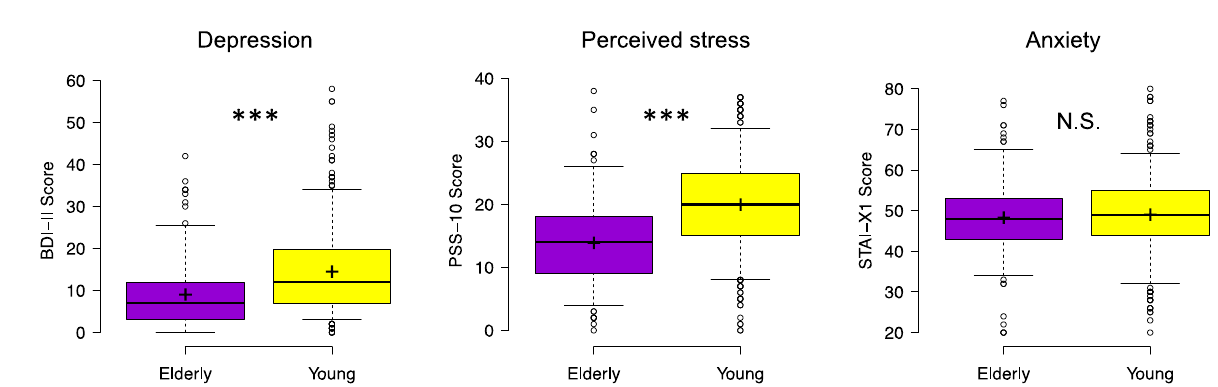
Figure 2. Depression symptoms (BDI-II), perceived stress (PSS-10), and anxiety (STAI-X1) for elderly and young respondents during the COVID-19 lockdown. Center lines show the medians; box limits indicate the 25th and 75th percentiles; whiskers extend to 5th and 95th percentiles, dots represent outliers; crosses represent sample means. Significant differences of Kruskal-Wallis test between elderly (violet) and young (yellow) participants are indicated with asterisks (*** p < 0.001). Abbreviations: BDI-II, Beck Depression Inventory-second edition, PSS-10, Perceived Stress Scale-10; STAI-X1, state-anxiety subscale of the State-Trait Anxiety Inventory; N.S., not